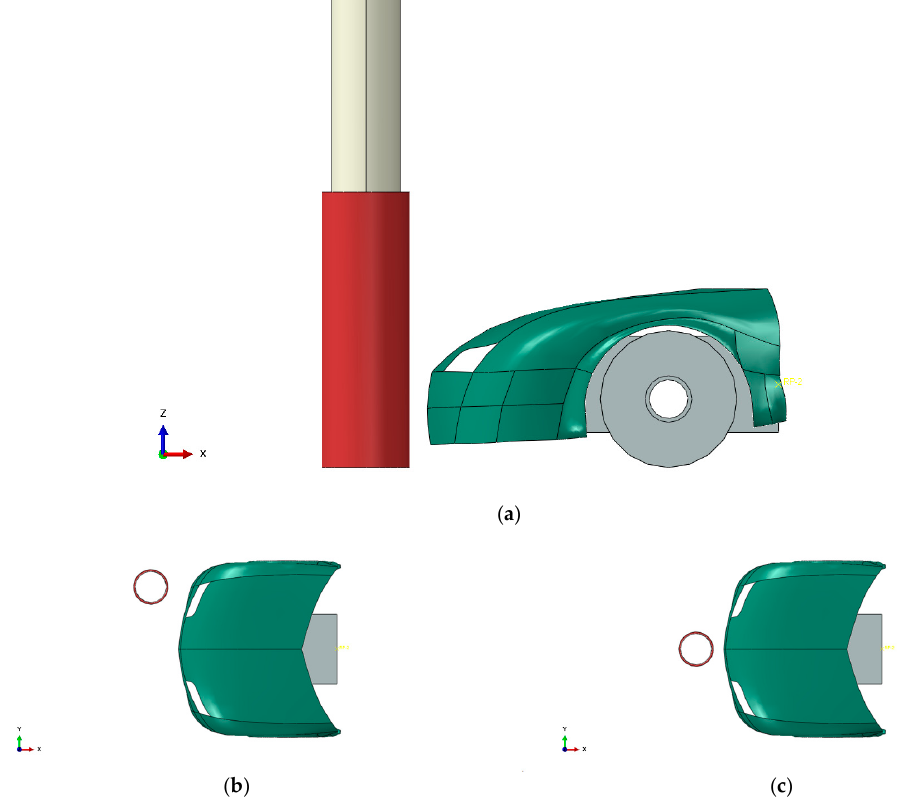
Figure 3. Model setup of the ( a ) vehicle colliding against a TDM-shielded steel street pole with supporting top views to observe the ( b ) corner collision and ( c ) frontal collision scenarios.